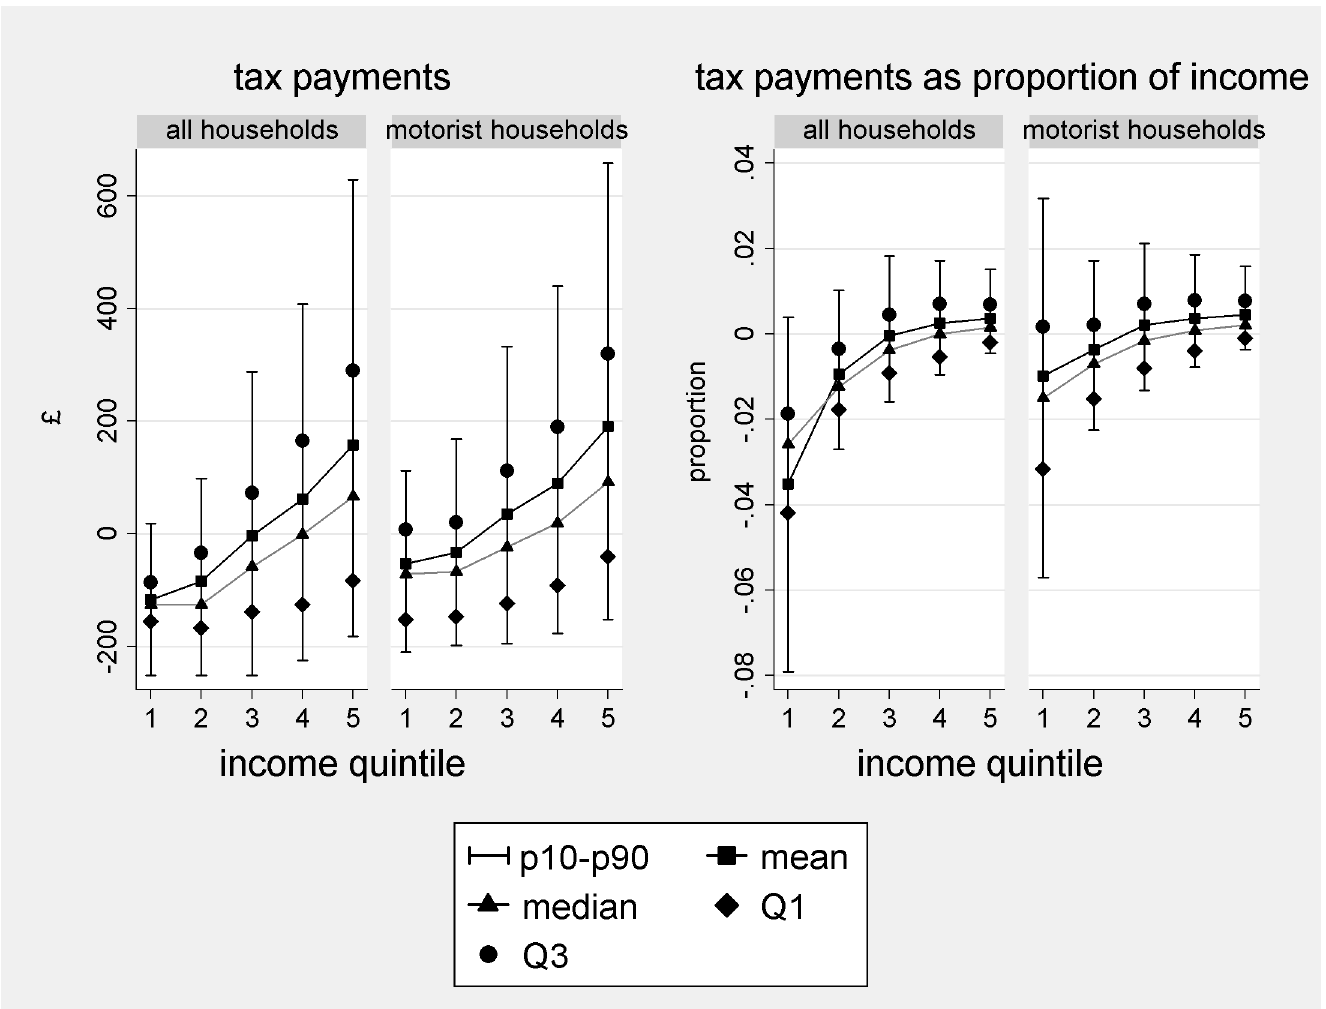
Fig 9. Estimated monetary effectsof a ‘cap and share’ or ‘tax and dividend’ policy at £100/tCO 2 . Note: ‘diary sample’weights applied,recalculated for the pooledsample.